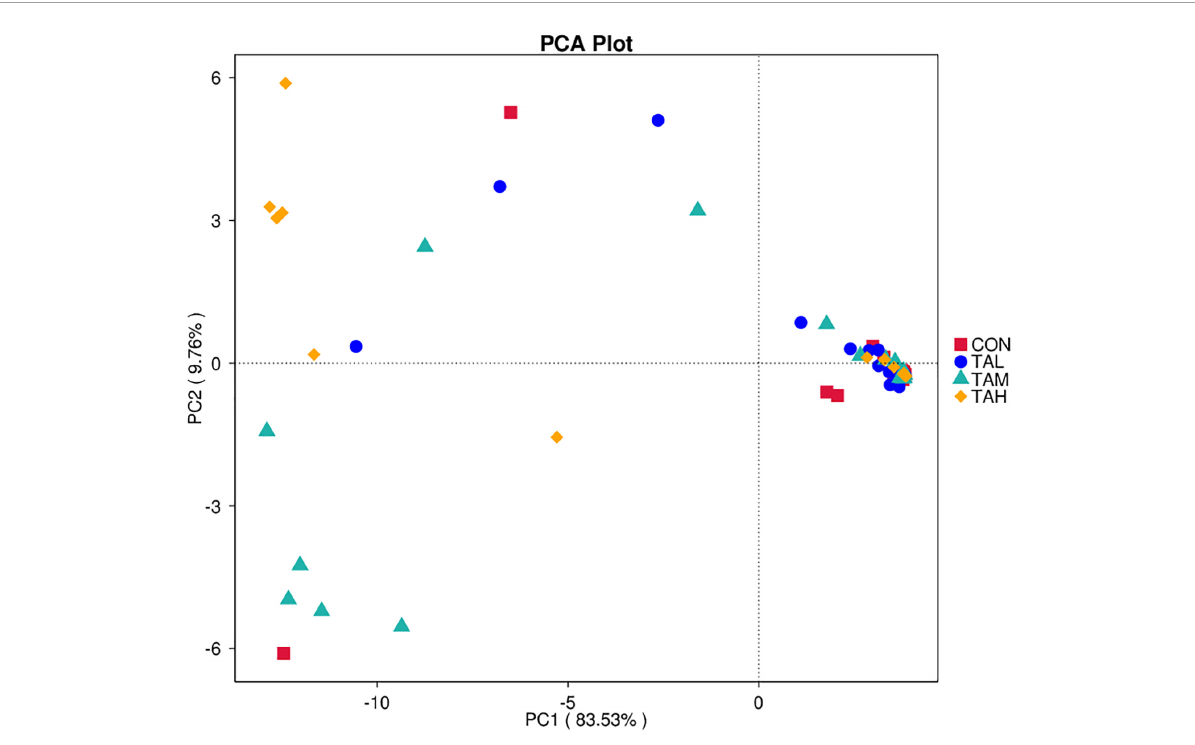
FIGURE5 The principle component analysis (PCA) plot for the predicted metagenome across the four treatments based on